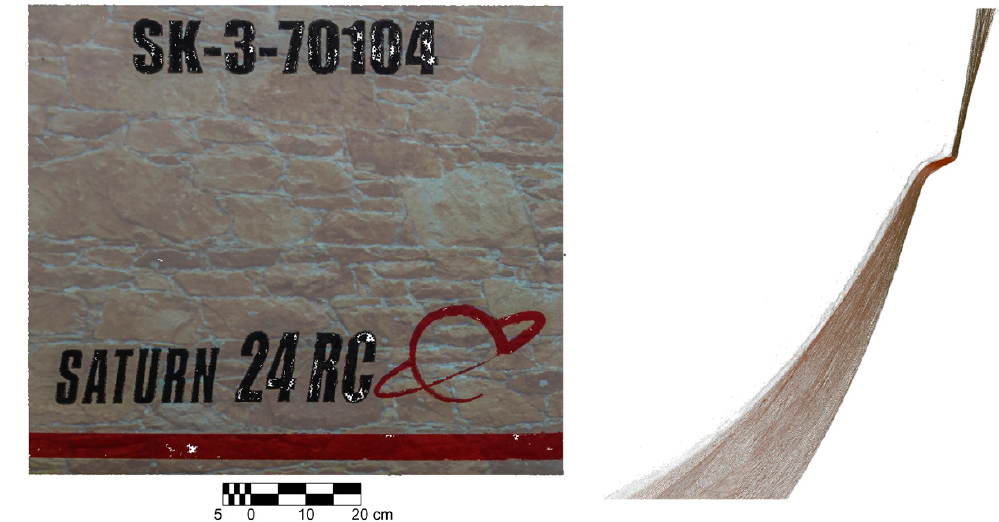
Figure 16. Left—a portion of the final textured point cloud; right—detailed cross-section.